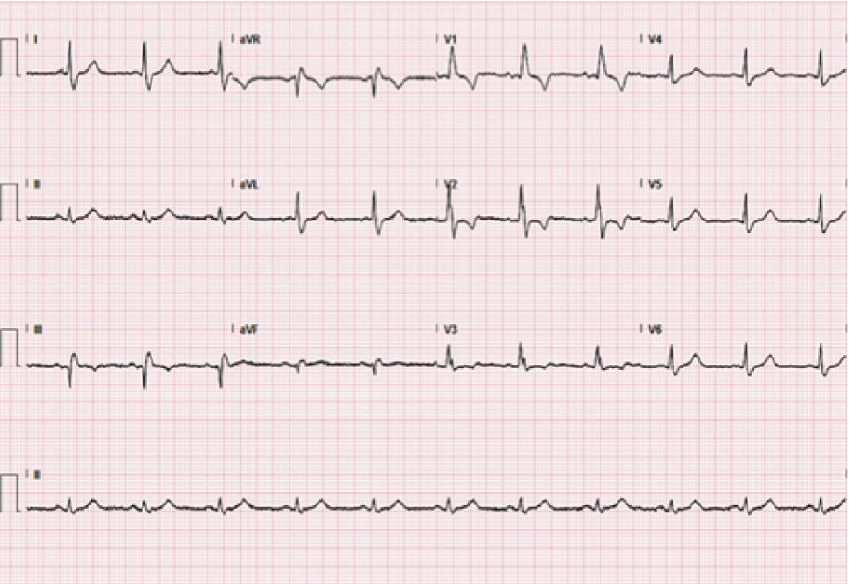
Figure 1: 12-lead electrocardiogram showing sinus rhythm with right bundle branch block.